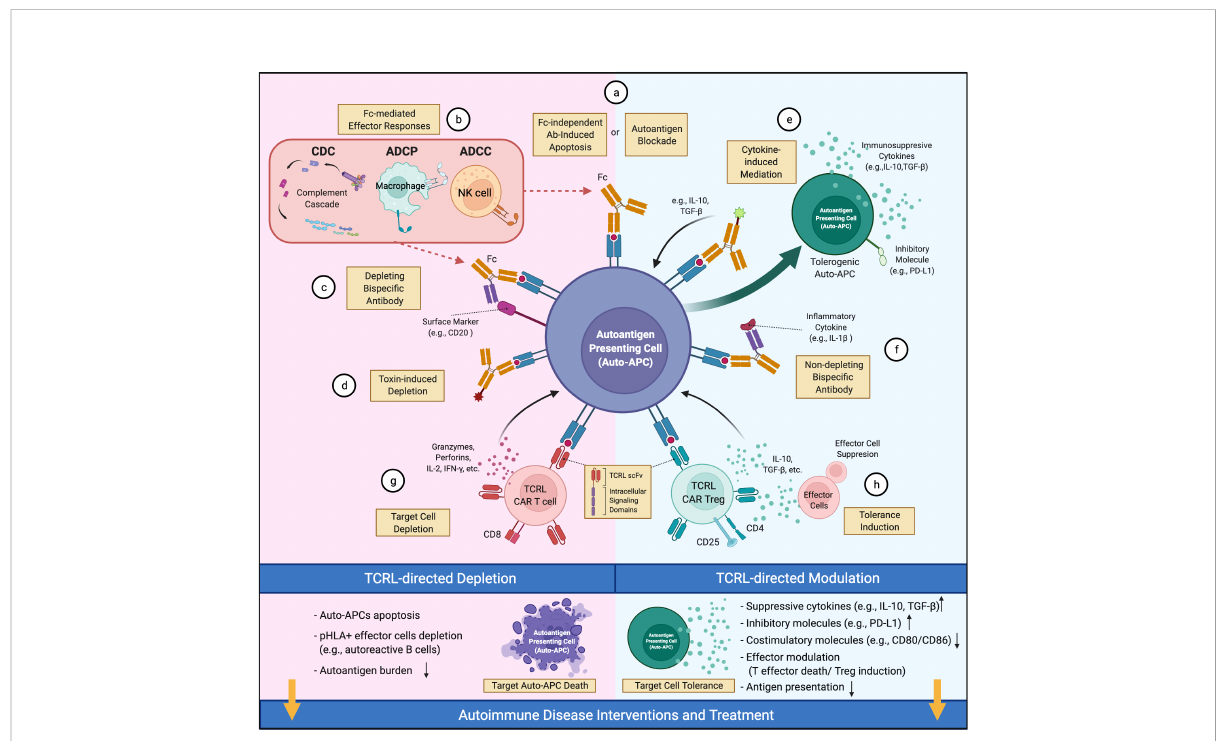
FIGURE 1 Therapeutic potential of TCRL mAbs in autoimmune diseases. TCRL mAbs speci fi c for autoantigen/HLA complexes can elicit therapeutic effects via depleting (pink) or non-depleting (cyan) mechanisms. (A) TCRL mAbs either block autoantigen presentation or induce apoptosis of target cells. (B) TCRL mAbs induce Fc-mediated cytotoxicity through various effector mechanisms. (C, F) Bispeci fi c antibodies targeting autoantigen/ HLA complexes and either a surface marker of target cells or a pathogenic-related cytokine; (D) TCRL mAb – toxin conjugates induce auto-APC depletion by payload effector molecules, including cytokines, toxins or radioactive substances. (E) TCLR mAb-cytokine conjugates guide the delivery of immunomodulatory cytokines (e.g., IL-10, TGF- b ) to auto-APCs for tolerance induction. (G) TCRL scFv fragments are reformatted into CARs for auto-APC targeting and depletion. (H) CD4+CD25+ TCRL CAR T reg cells suppress T eff function and induce tolerance. (This fi gure was created with